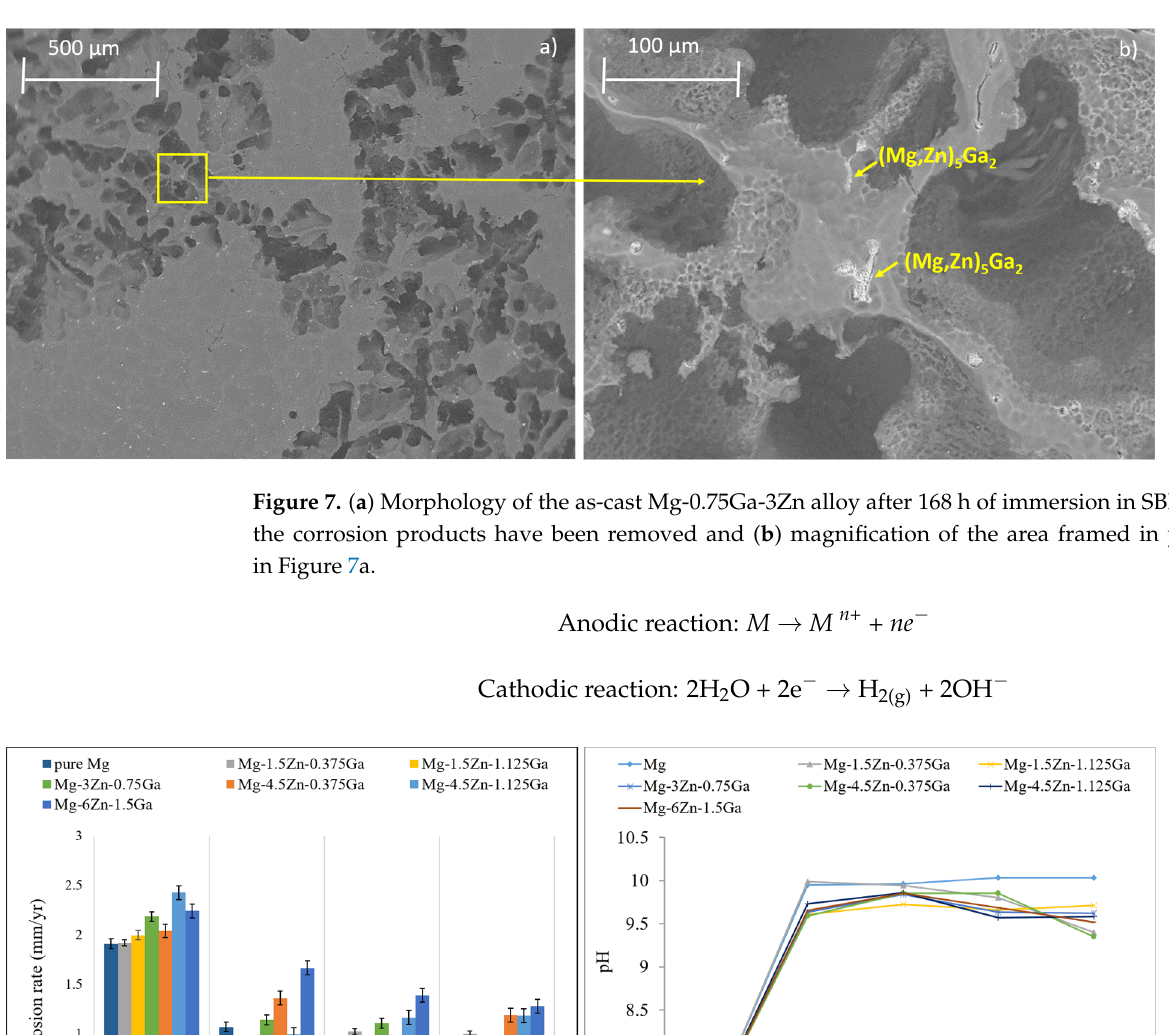
Figure 9. Ionic concentration of remaining SBFs, ( a ) Mg, ( b ) Ca and ( c ) P after 168 and 336 h of immersion of the alloys.